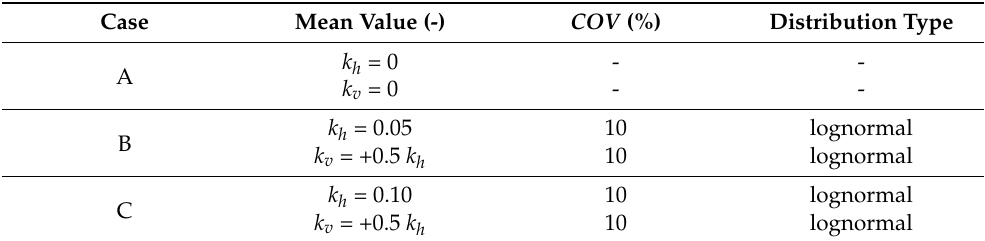
Table 5. Statistical values for the seismic